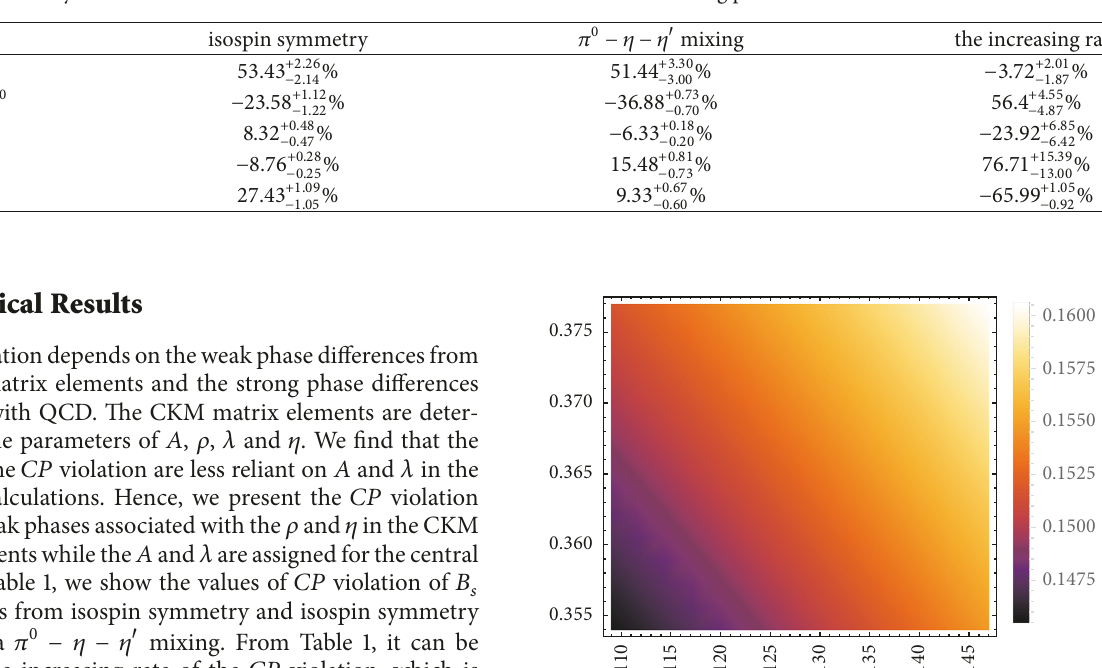
Table 1: The CP violation of 𝐵 𝑠 decay mode via isospin symmetry and isospin symmetry breaking via 𝜋 0 − 𝜂 − 𝜂 󸀠 mixing. The increasing breaking, respectively. The fluctuation numerical values refer to the contribution of the limiting parameters from the CKM matrix elements.